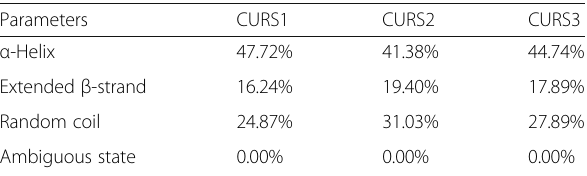
Table 2 Prediction of secondary structure of CURS proteins by SOPMA